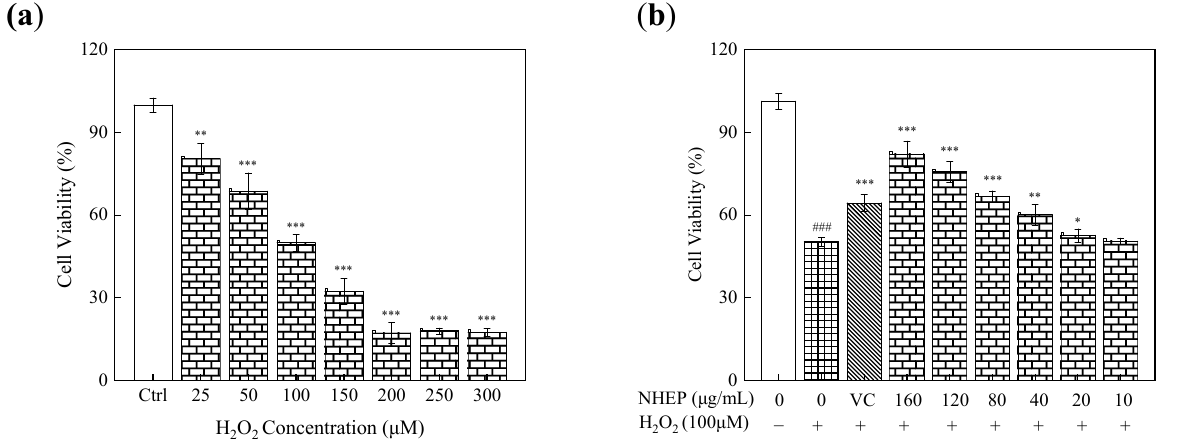
Figure 9. Cytotoxicity of H 2 O 2 and NHEP on HaCaT cells. ( a ) viability of the HaCaT cells cultured with the H 2 O 2 , ( b ) viability of the HaCaT cells cultured with H 2 O 2 and NHEP. VC stands for Vitamin C, and the concentration is 10 µ g/mL. Significance: ### p < 0.001 compared with the control group. * p < 0.05, ** p < 0.01, *** p < 0.001 compared with the H 2 O 2 stimulation group. The data shows as the mean ± S.D. ( n = 5).